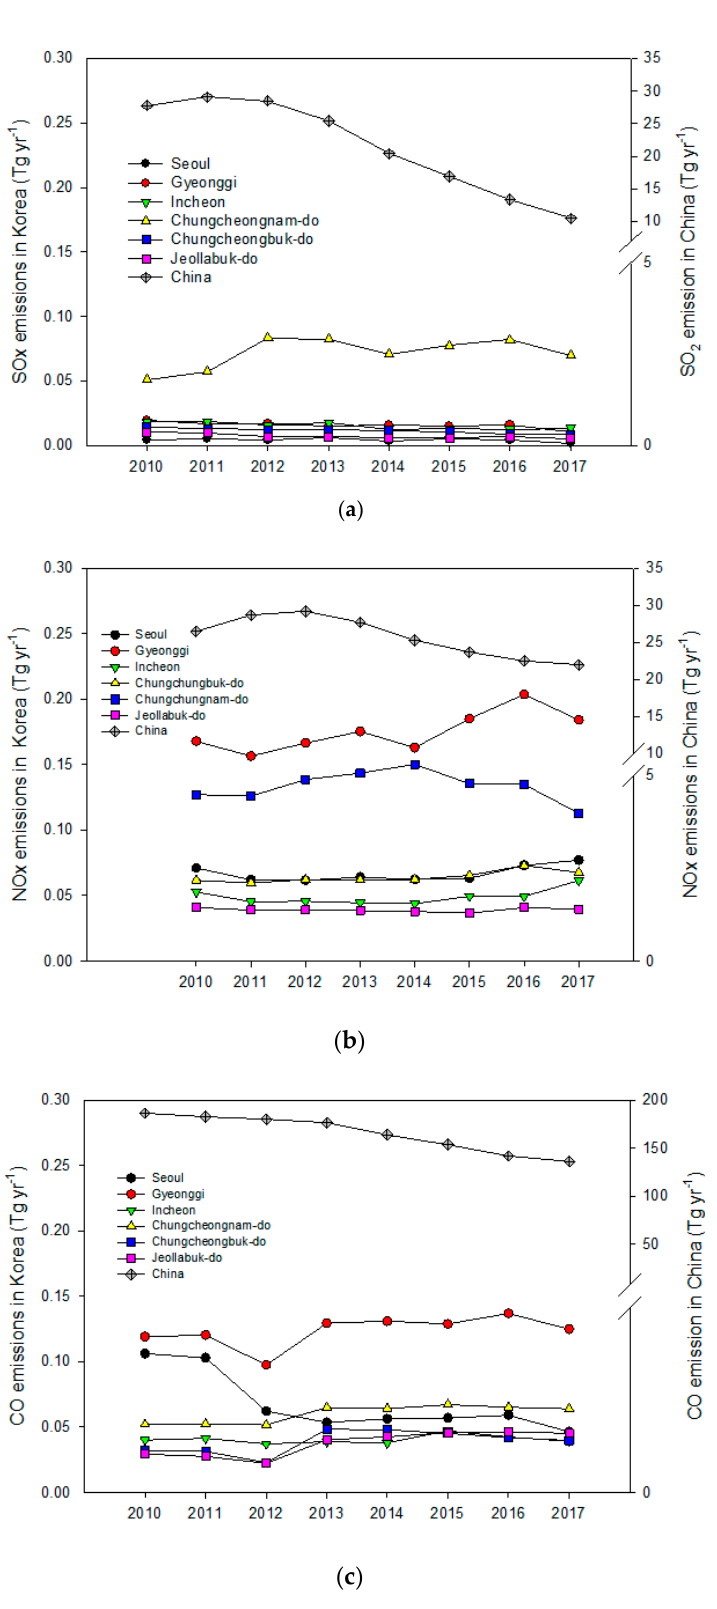
Figure 3. Emissions of SOx, NOx and CO in China and South Korea. ( a ) SOx (SO 2 ), ( b ) NOx and ( c ) CO. The SO 2 emissions in China and the metropolitan areas of South Korea were all on a downward trend. Only in Chungcheongnam-do were SO 2 emissions found to be on the rise. Large-scale coal-fired power plants and industrial complexes are located